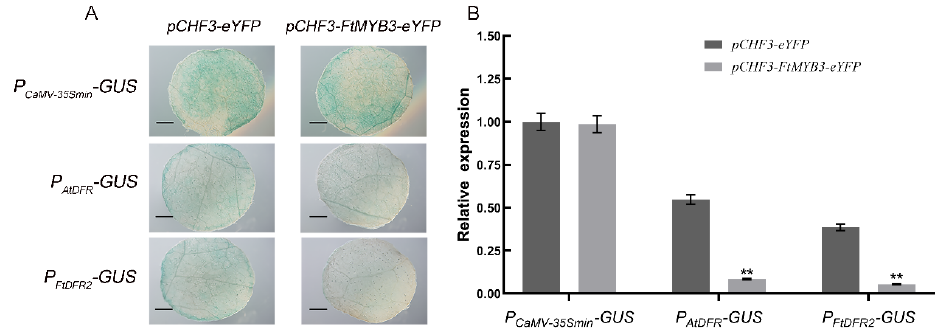
Figure 7. Inhibition of FtMYB3 on the DFR promoter in instantaneous transfected tobacco producing FtMYB3-eYFP together with the GUS gene under the control of the P CaMV-35Smin -GUS , P AtDFR -GUS and P FtDFR2 -GUS , respectively. ( A ) Staining of GUS protein. Tobacco leaves that were about 4 weeks old were used for transient transformation analysis, and GUS protein was stained 48 h after injection; ( B ) Relative expression of GUS gene. Error bars indicate ± SDs. ** means significant difference at p < 0.01